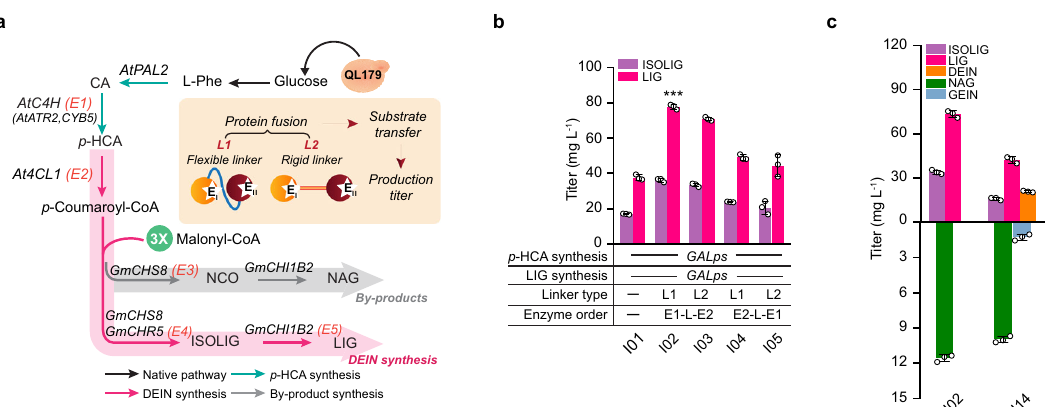
Fig. 5 Gene ampli fi cation and engineering of substrate traf fi cking improve DEIN production. a Schematic view of the targets and strategies to improve the substrate transfer along the DEIN biosynthetic pathway. Two different oligopeptide linkers ( fl exible linker L1, GGGS; rigid linker L2, VDEAAAKSGR) were employed to fuse the adjacent metabolic enzymes. Strain QL179 was selected to implement GAL promoters ( GALps )-mediated gene ampli fi cation. See Fig. 1 and its legend regarding abbreviations of metabolites and other gene details. b Quanti fi cation of metabolic intermediates produced by strains carrying a fused enzyme of AtC4H (E1) and At4CL1 (E2). c Comparison of the production pro fi les between parental strain I02 and I14 harboring additional overexpression of selected metabolic enzymes Ge2-HIS and GmHID and auxiliary CrCPR2. Cells were grown in a de fi ned minimal medium with 30gL − 1 glucose as the sole carbon source and 10gL − 1 galactose as the inducer. Cultures were sampled after 72h of growth for metabolite detection. Statistical analysis was performed by using Student ’ s t test (two-tailed; two-sample unequal variance; * p <0.05, ** p <0.01, *** p <0.001). All data represent the mean of n = 3 biologically independent samples and error bars show standard deviation. The source data underlying panels ( b , c ) are provided in a Source Data fi